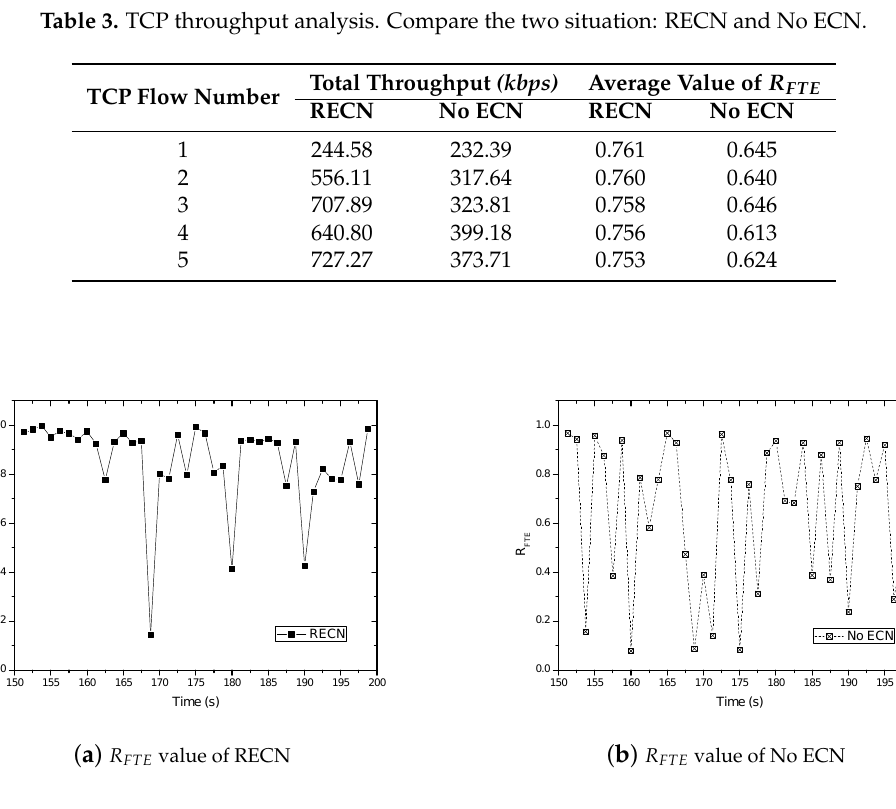
Figure 6. Comparison of the R FTE value (TCP flow number: